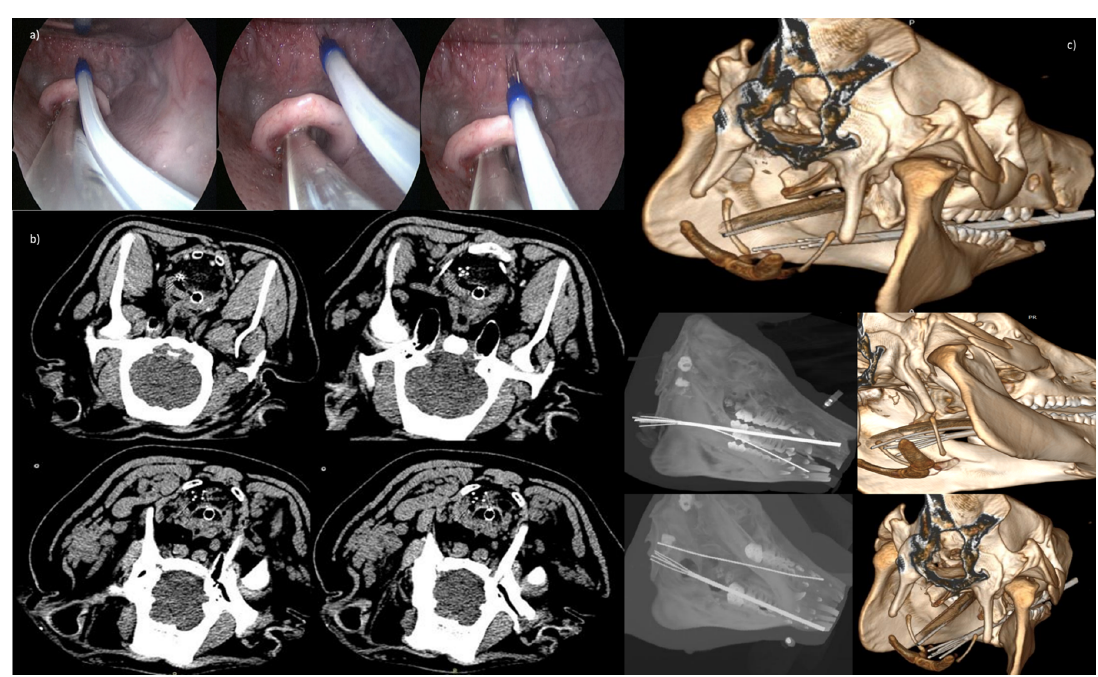
Figure 7. ( a ) Trans-oral application for intraluminal access to upper airways with the 5-needle